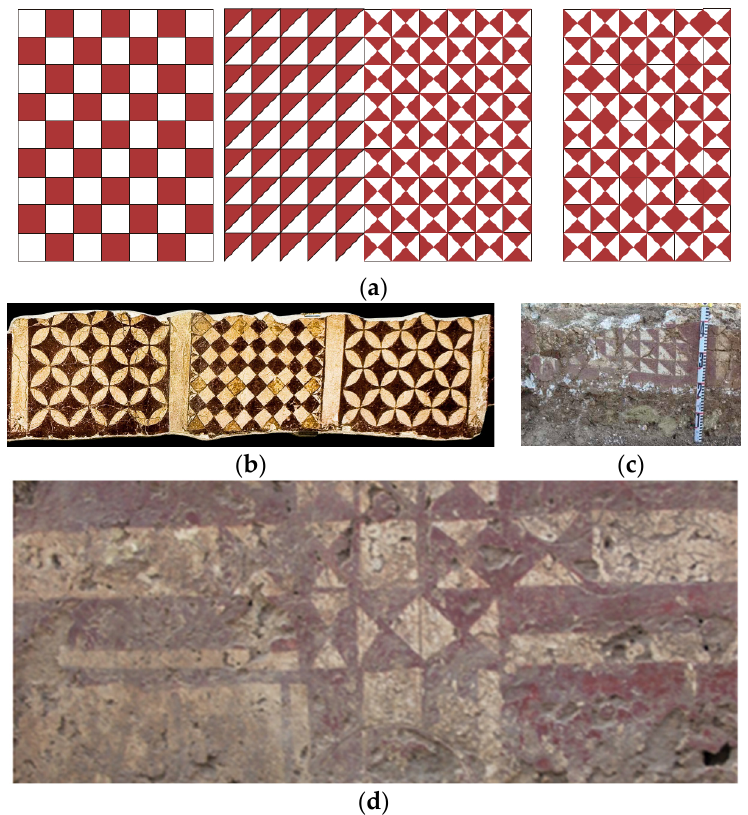
Figure 5. Geometric coatings in the 10–11th centuries: ( a ) Bayyana (Pechina), Almería (García Gra- nados 2014b, p. 5); ( b ) Méndez Núñez Street, Almería (García Granados 2014b, p. 7); ( c ) Huerta de San Pedro, Córdoba (Córdoba 2006, Figure 5, p. 300); ( d ) Ollerías Avenue, Córdoba (López 2006).